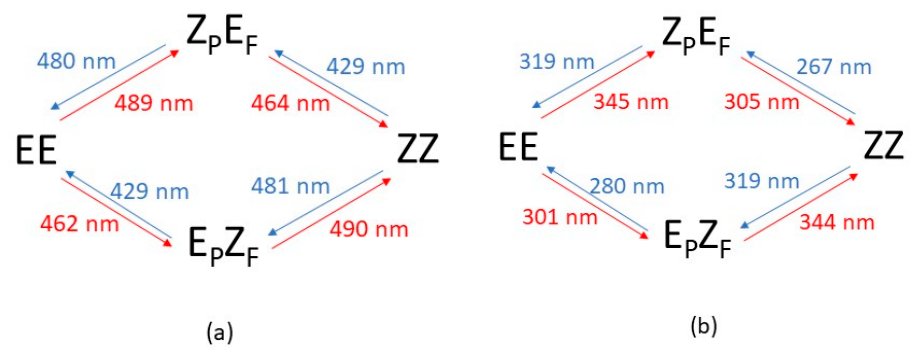
Figure 8. Allowed photo-isomerizations for dimer 2. ( a ): Activated through low-energy photoexcita- tion ( λ > 425 nm). ( b ): Activated through high-energy photo-excitation ( λ < 350 nm).